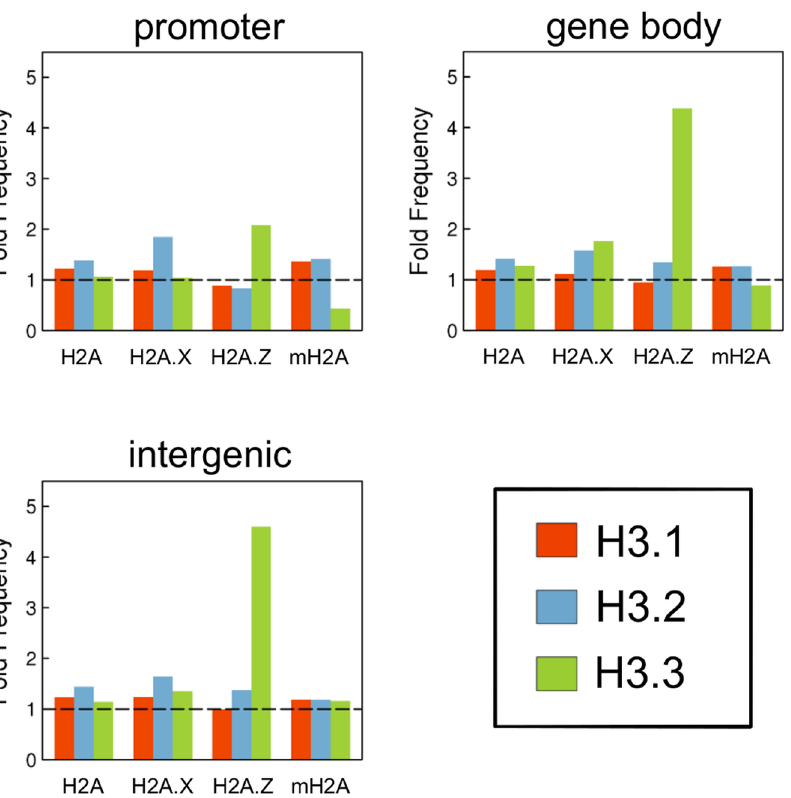
Figure 7. Preferred combination of H2A and H3 variants in various genome regions. The genome was divided into 150 nucleotide bins, and the bins in which a particular variant was significantly enriched were determined as described in the Materials and Methods ( see Figure S4). The frequency of bins in which two H2A and H3 variants were simultaneously enriched was determined for all combinations of H2A and H3 variants. Bars represent the ratios of the frequencies determined as described above to those of the expected values calculated from the number of bins in which each variant was enriched. Therefore, values . 1.0 indicate a preference for that particular H2A and H3 variant combination.